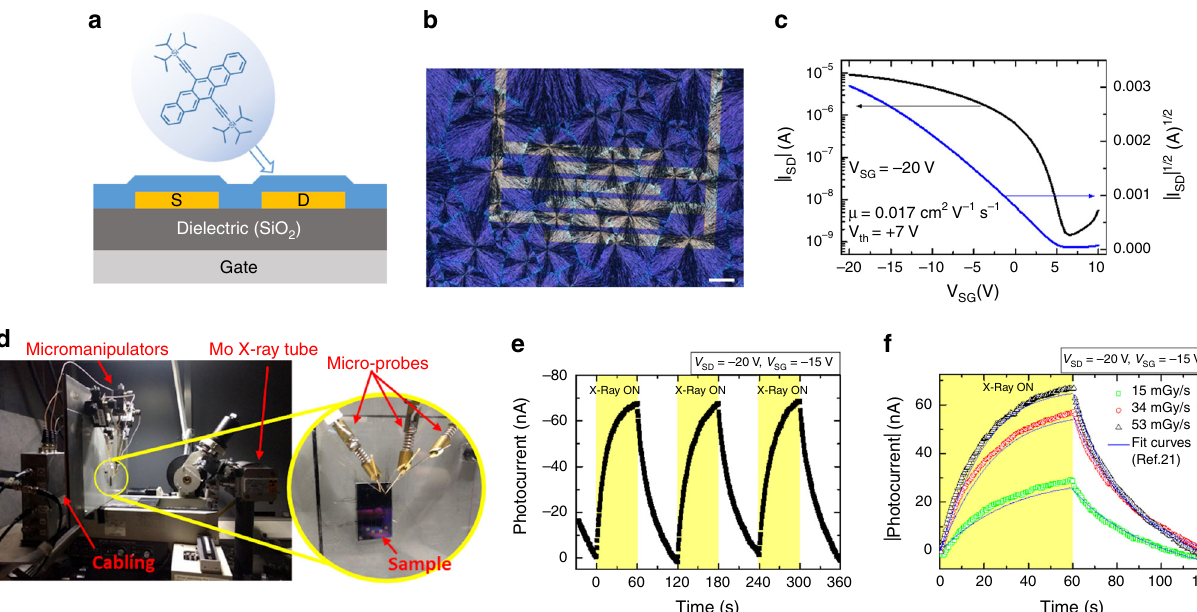
Fig. 1 BAMS deposited TIPS-pentacene OFETs as X-ray detectors. a Schematic representation of the bottom-gate bottom-contact OFETs employed in this work, showing the cross section of the devices and the molecular structure of TIPS-pentacene. b Cross-polarized optical microscope image of a pure TIPS-pentacene thin fi lm deposited by BAMS on a Si/SiO 2 substrate with pre-patterned interdigitated electrodes. Scale bar is 100 µ m. c Typical transfer characteristics in the saturation regime of a pure TIPS-pentacene OFET. d Photograph of the experimental setup for the samples irradiation with a Mo- target X-ray tube. e X-ray induced photocurrent response of a pure TIPS-pentacene BAMS-coated device upon three on/off switching cycles (yellow areas, time windows of 60 s) employing a dose rate of 53 mGy s − 1 , reaching a high sensitivity value of 3.8 · 10 2 µ C Gy − 1 cm − 2 . f Experimental and fi tted curves of the response of the same device for three different dose rates of radiation yielding an ampli fi cation of the photocurrent of 2 · 10 6 . The fi t curves have been obtained by applying the analytical model described in ref. 21